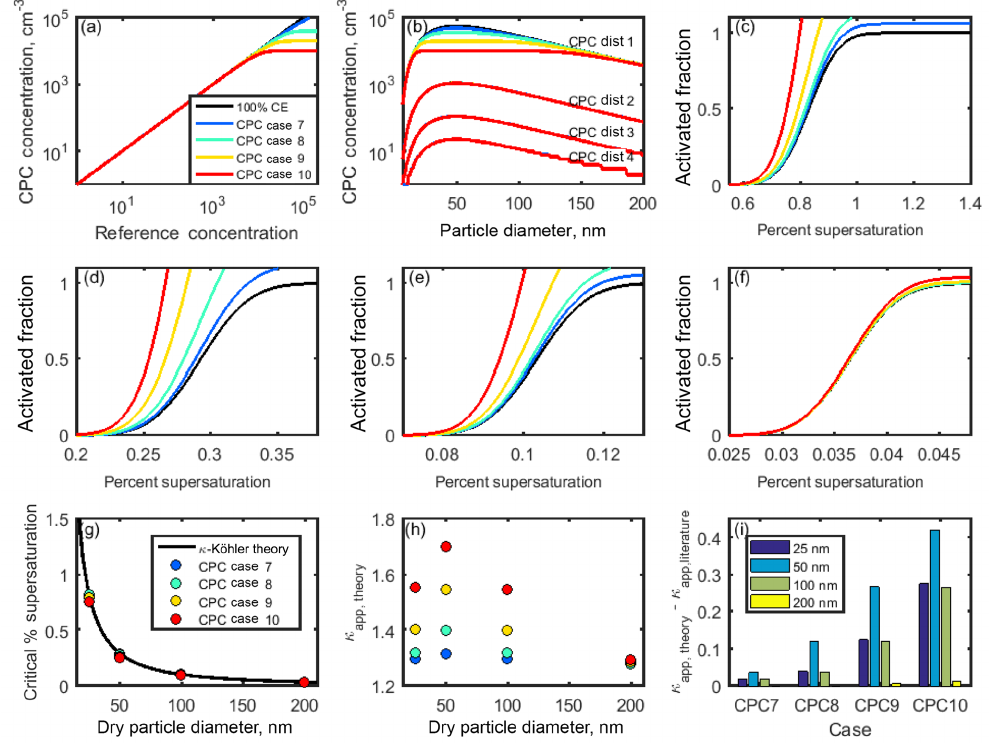
Figure 8. (a) Theoretical relationships between the reference aerosol concentration and CPC concentration. (b) Concentration-dependent counting efficiencies from (a) were applied to four theoretical aerosol distributions. (c–f) Activated fraction curves for CPC distribution 1 and particle diameters 25, 50, 100, and 200nm NaCl aerosol, respectively. (g,h) Critical supersaturation and κ app for each case. (i) Artifacts in κ app for each